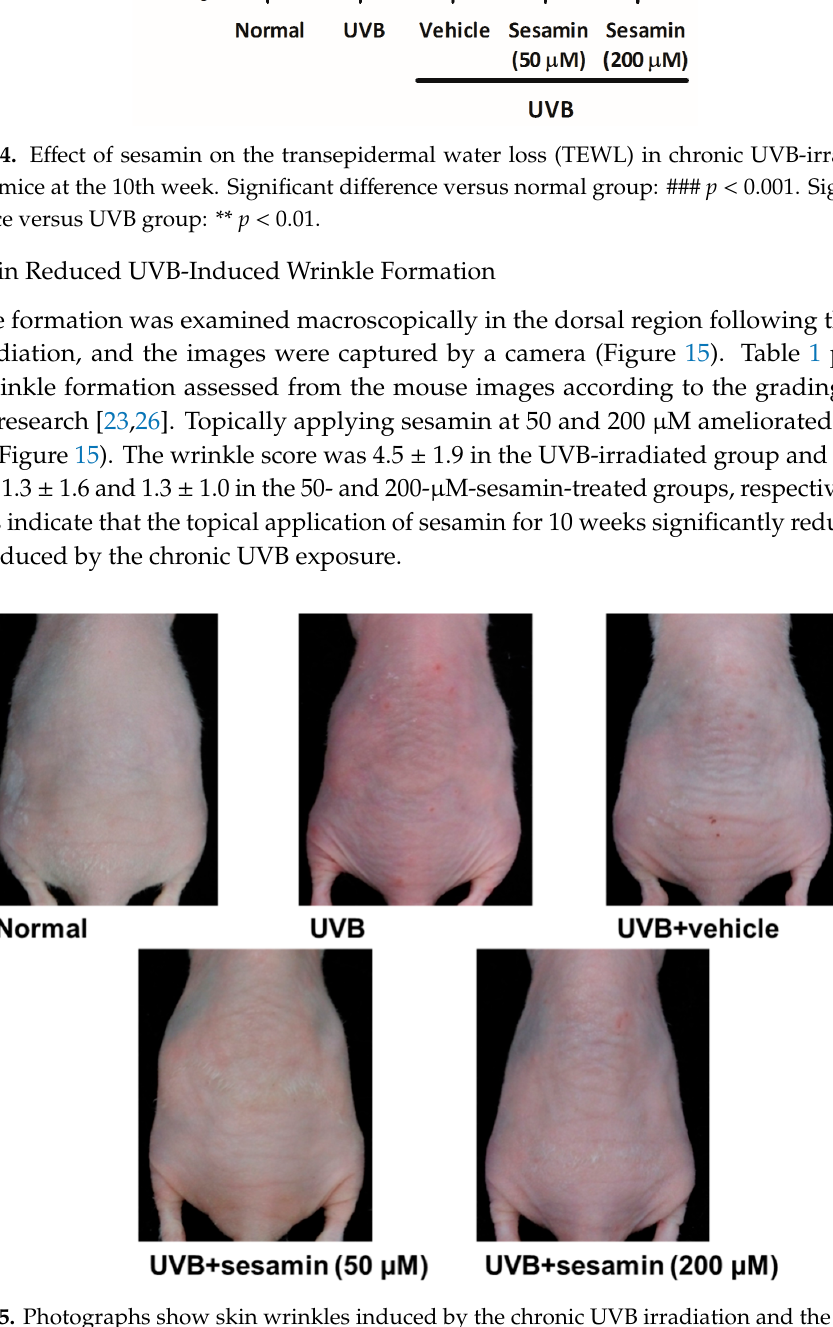
Figure 15. Photographs show skin wrinkles induced by the chronic UVB irradiation and the e ff ect of topically applied